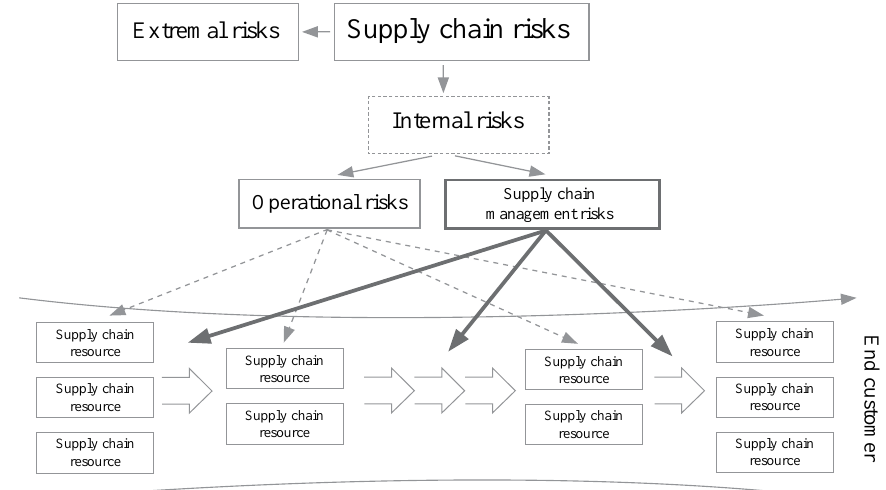
Fig. 4. Supply chain